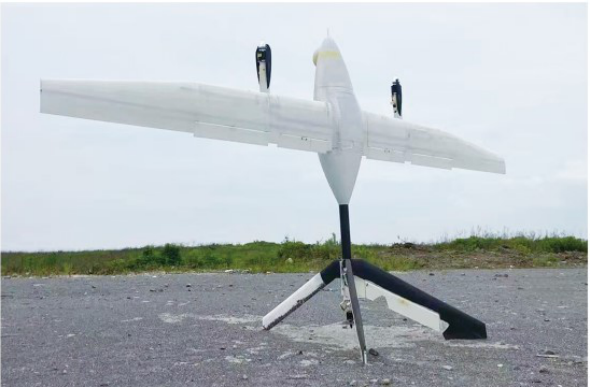
Figure 1. ETS-20 Tail-sitter VTOL